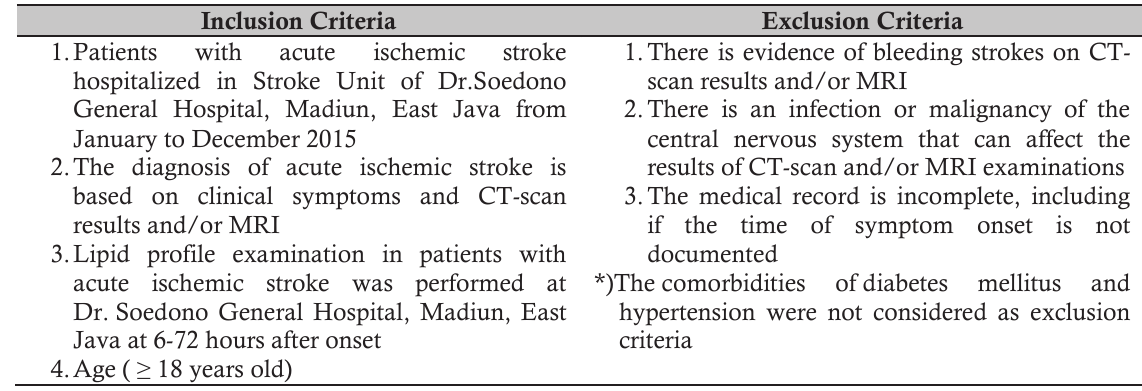
Table 1. Inclusion and Exclusion Criteria of the research